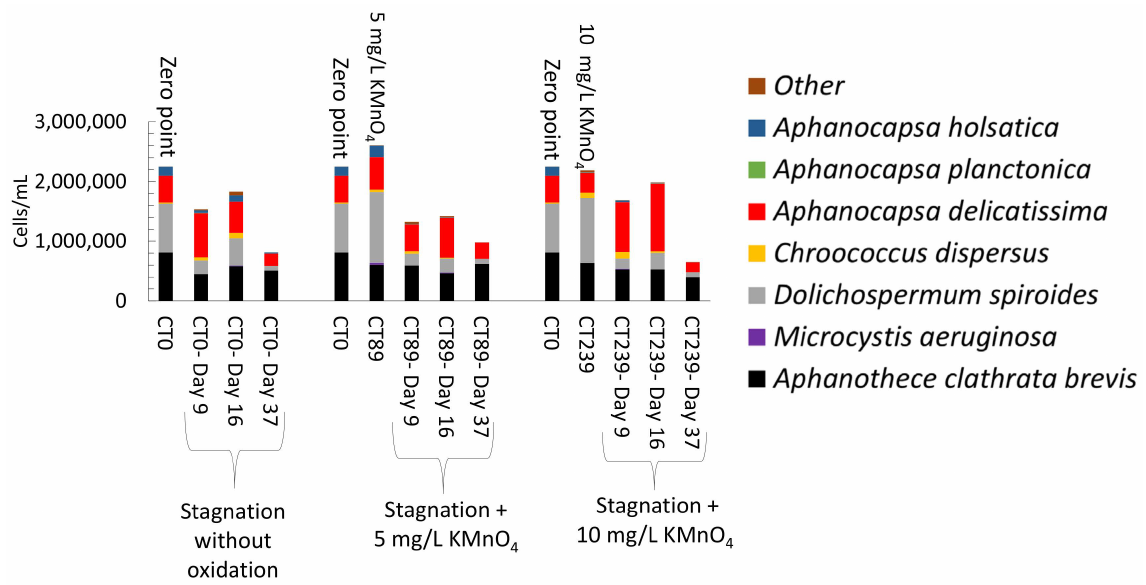
Figure 1. Fate of cyanobacterial cells (taxonomic cell counts) during sludge oxidation and stagnation in the laboratory on 31 July using 5 and 10 mg/L KMnO 4 . Zero point: Before oxidation, CT: exposure (mg · min/L), Day: stagnation